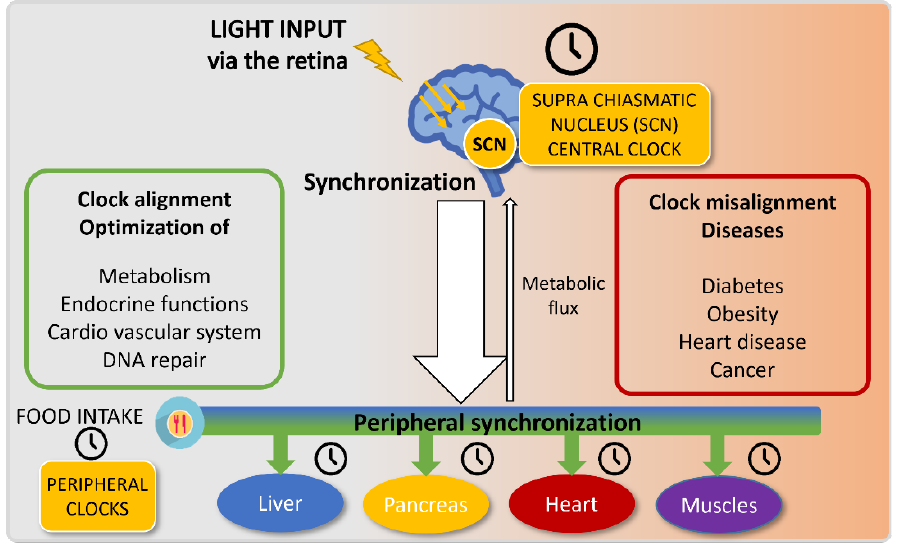
Figure 2. Circadian clock entrainment.